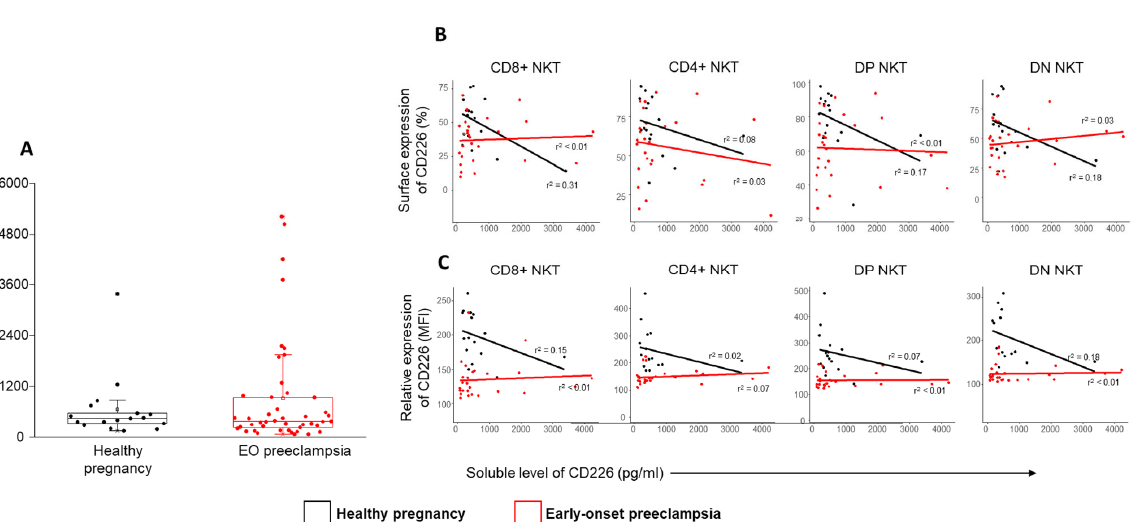
Figure 8. Relationship between the surface expression or the relative expression of CD226 and the level of soluble CD226 in NKT subpopulations in EOP and healthy pregnancy. The serum concen ‐ tration of CD226 ( A ) molecule in EOP patients and healthy control women. The solid bars represent medians, the boxes indicate the interquartile ranges and the lines show the most extreme observa ‐ tions. Linear regression analyses between the CD226 surface ( B ) or relative expression ( C ) with the sCD226 level in different NKT subsets in EOP and healthy control women. p values and coefficients of determination (R 2 ) were calculated in R.